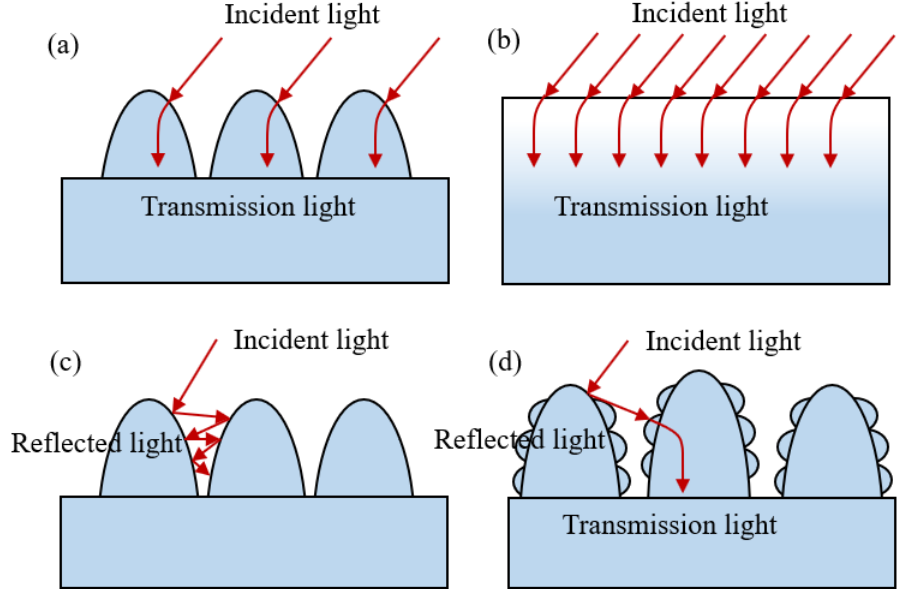
Figure 2. Schematic diagram of light acting on different structure sizes. ( a , b ) subwavelength structure; ( c ) micrometer structure; ( d ) multiscale structure.